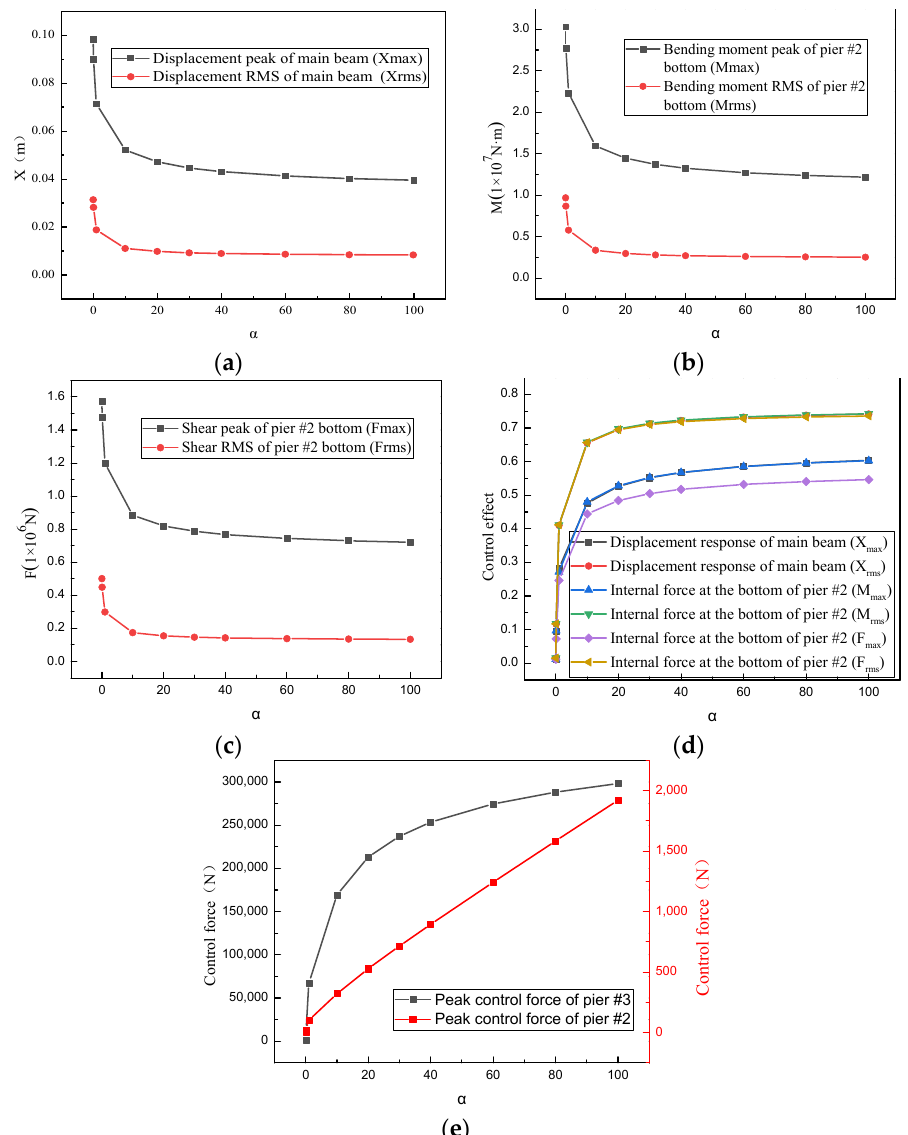
Shear peak of pier #2 bottom (Fmax) Shear RMS of pier #2 bottom (Frms)